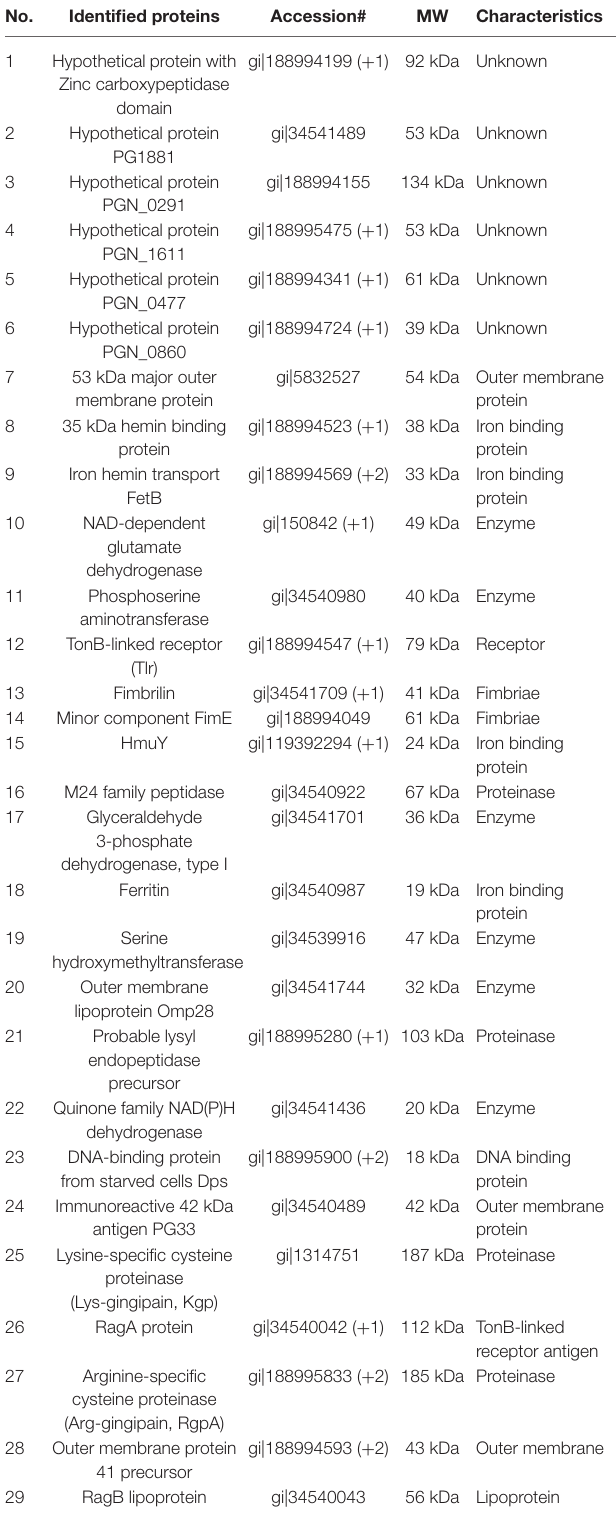
TABLE 2 | List of P. gingivalis antigens recognized by patients’ serum IgG.